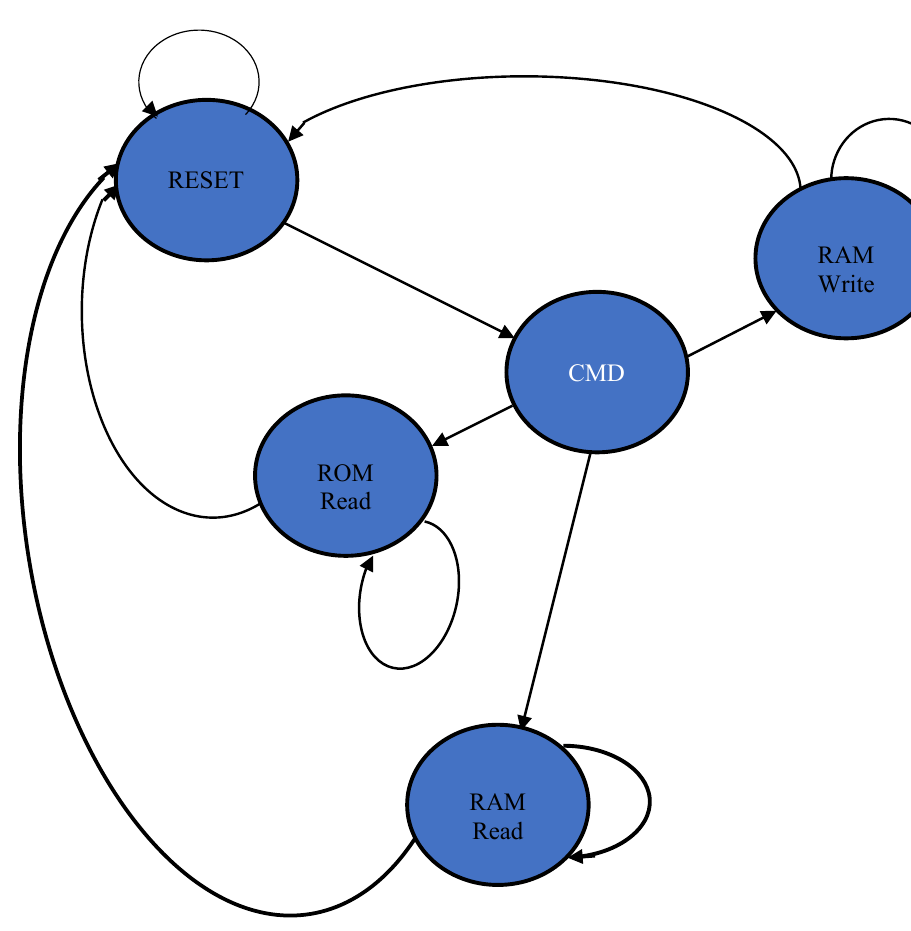
Fig. 7. State diagram for memory